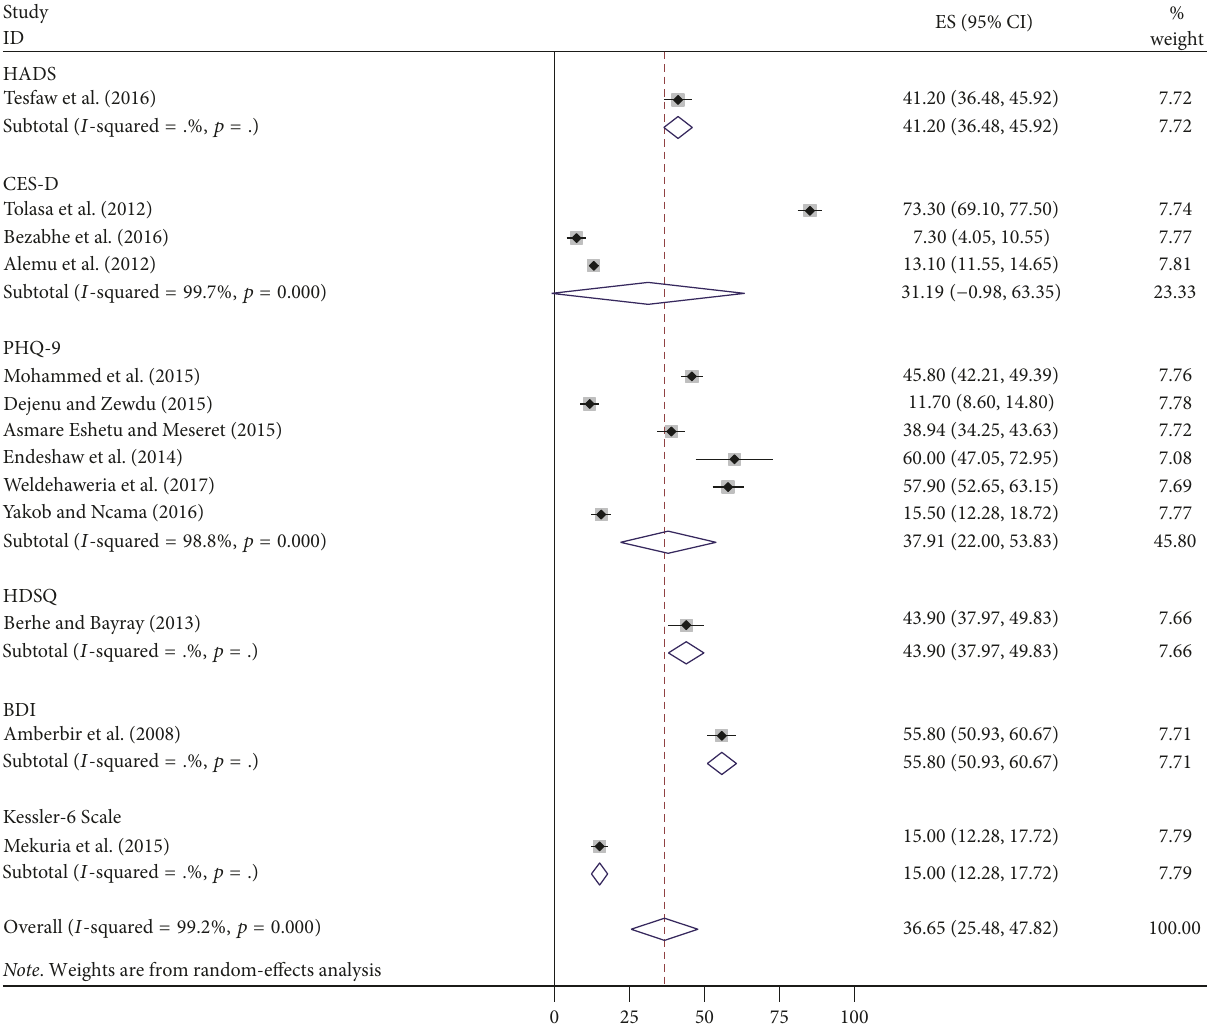
Figure 3: Forest plot presenting subgroup analysis of pooled estimated prevalence of depression according to the tool used among PLWHIV in Ethiopia,